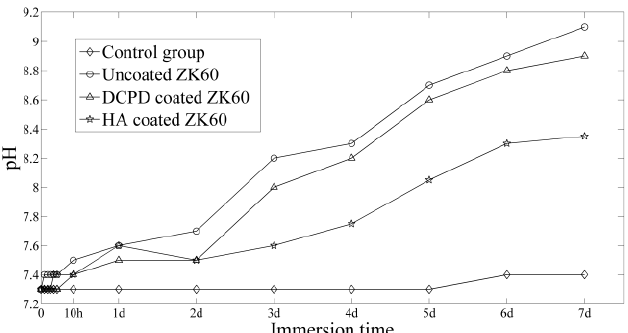
Figure 4. pH changes of the SBF during 7 day’s immersion